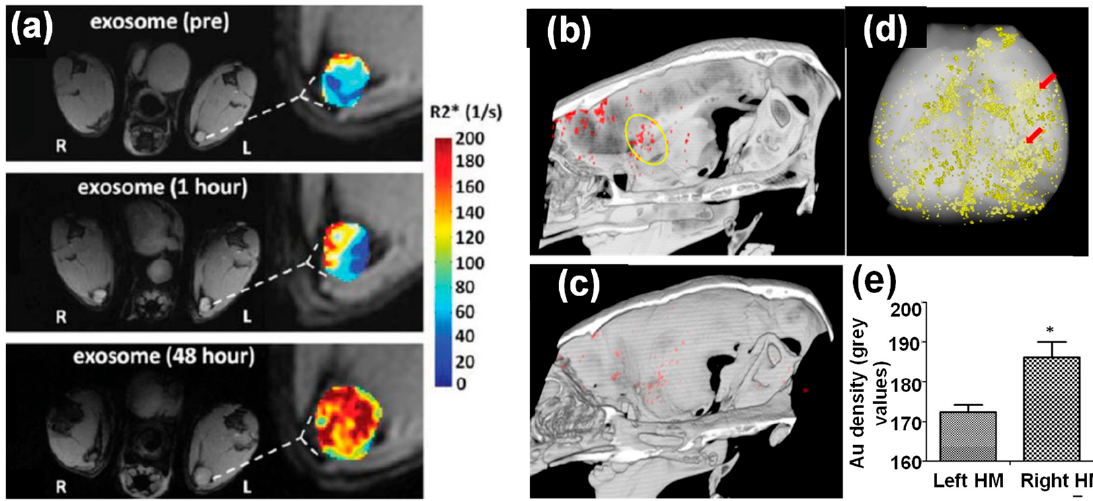
Figure 4. ( a ) In vivo MR imaging of mice injected with iron oxide nanoparticle-loaded exosomes derived from melanoma cells. After 48 h footpad injection, the T1 -weighted images and R2* mapping clearly suggested accumulation of exosomes in lymph node [42]. ( b–e ) In vivo CT imaging of Au nanoparticle-loaded exosomes after intranasal administration into mice with acute striatal stroke: ( b ) a CT image 24 h post-administration (the ischemic region is indicated by the yellow circle), ( c ) a CT image of control animal with saline injection, ( d ) ex vivo CT imaging and Au quantification within the animal brain 24 h post administration, and ( e ) CT analysis of Au density of left and right hemispheres (note: stroke was introduced in the right hemisphere) [32].*: ( p < 0.05).